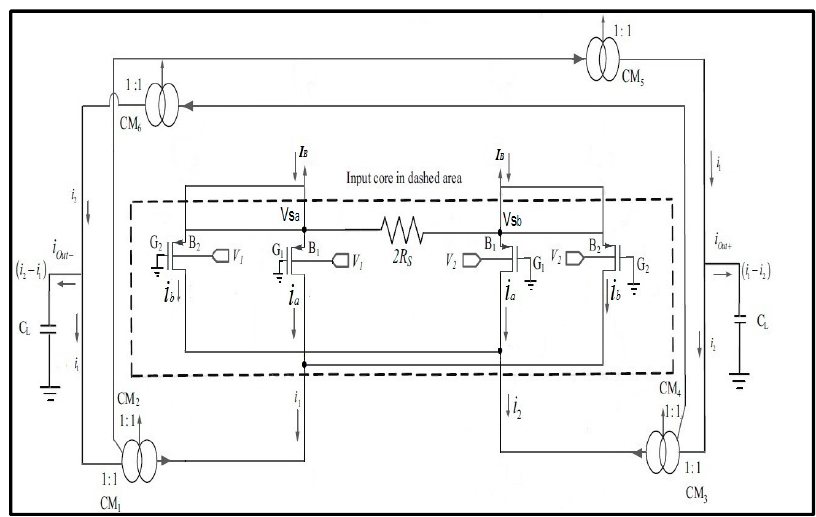
Figure 3. Block diagram of the fully differential operational transconductance amplifier (OTA).